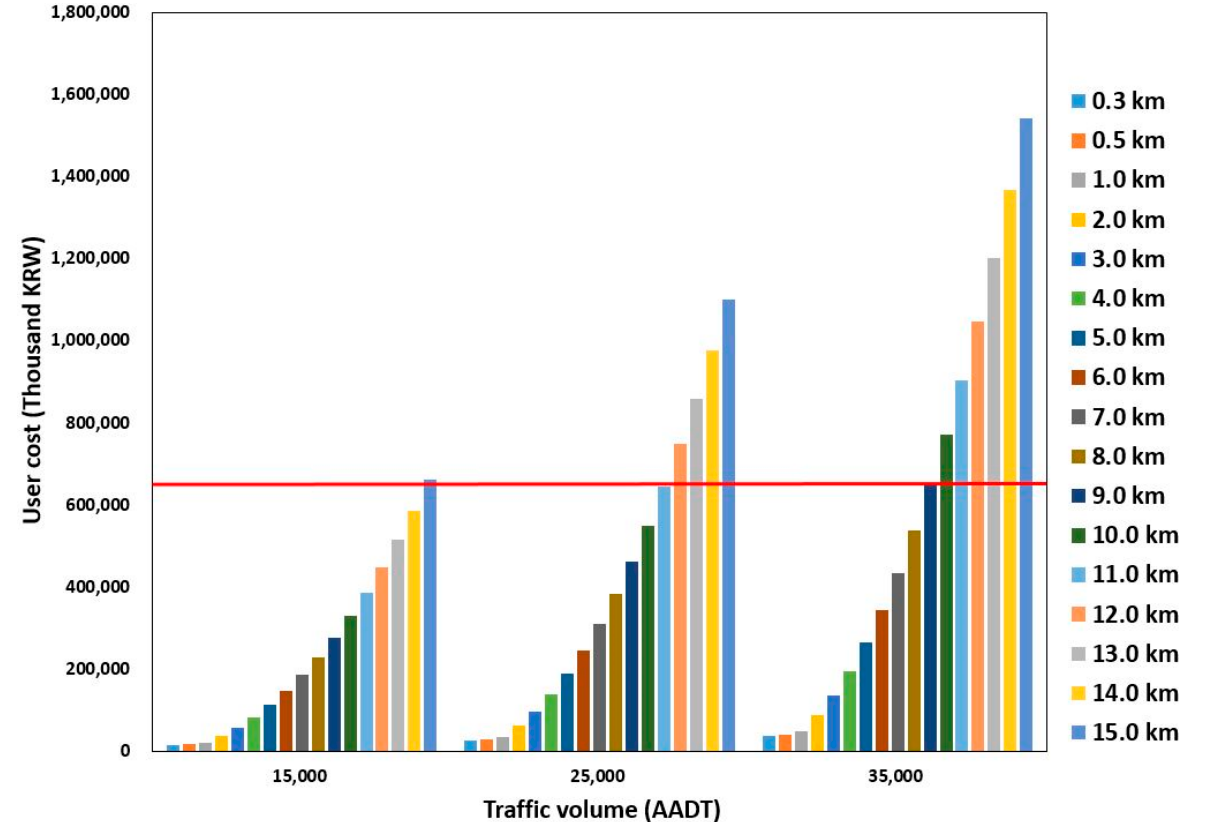
Figure 1. Relationship between traffic volume and user cost maintenance.